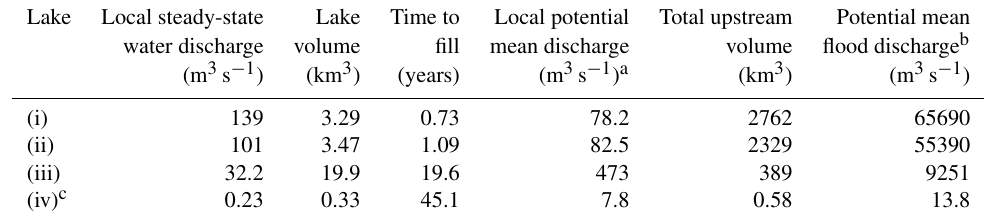
Figure 5. Modelled water flow beneath Pine Island and Thwaites glaciers at the LGM. (a) Modelled ice-sheet surface at 20ka (Golledge et al., 2012), showing the calculated drainage catchment of Pine Island and Thwaites glaciers in red. (b) Water discharge and flow routing paths for the entire Pine Island–Thwaites catchment at the LGM, calculated at a 500m grid resolution. The location of actively filling and draining subglacial lakes beneath the contemporary WAIS (Smith et al., 2017) is outlined in yellow. Areas of cold-based ice are displayed in white. (c) Modelled subglacial water discharges within the channelized inner-shelf region covered by high-resolution (90m) swath bathymetric data. The locations of four predicted lakes, referred to as examples in the text, are shown. The present-day ice margin from LIMA (U.S. Geological Survey, 2007) is displayed in (b, c, d) as a solid black line. (d) Geomorphologically mapped channel network within the high- resolution swath bathymetric data and modelled subglacial drainage network. The major flow routing pathways and subglacial lake locations calculated in (c) are displayed as red arrows and blue polygons in (d) , respectively. Only subglacial lakes with a steady-state discharge > 3m 3 s − 1 are displayed for visual simplicity. The labels “PIG” and “TG” mark the contemporary margins of Pine Island Glacier and Thwaites Glacier, respectively. Table 2. Volume, filling time, local steady-state discharge, and potential mean flood discharge of lakes displayed in Fig. 5. Lake Local steady-state Lake Time to Local